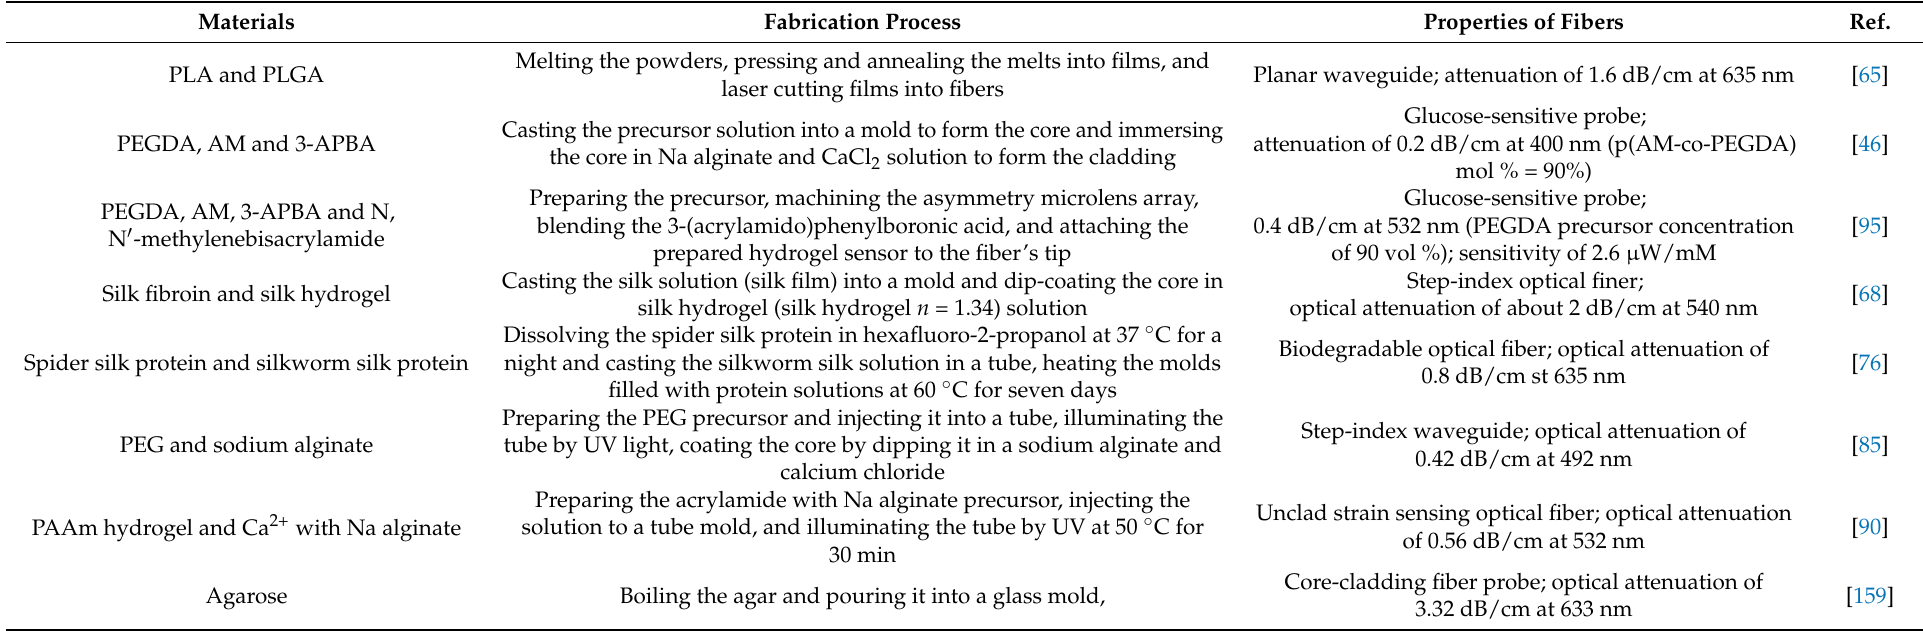
Table 7. Summary of optical fiber probes fabricated via casting, including main materials, brief introduction of the fabrication process, properties of obtained fibers, and their corresponding